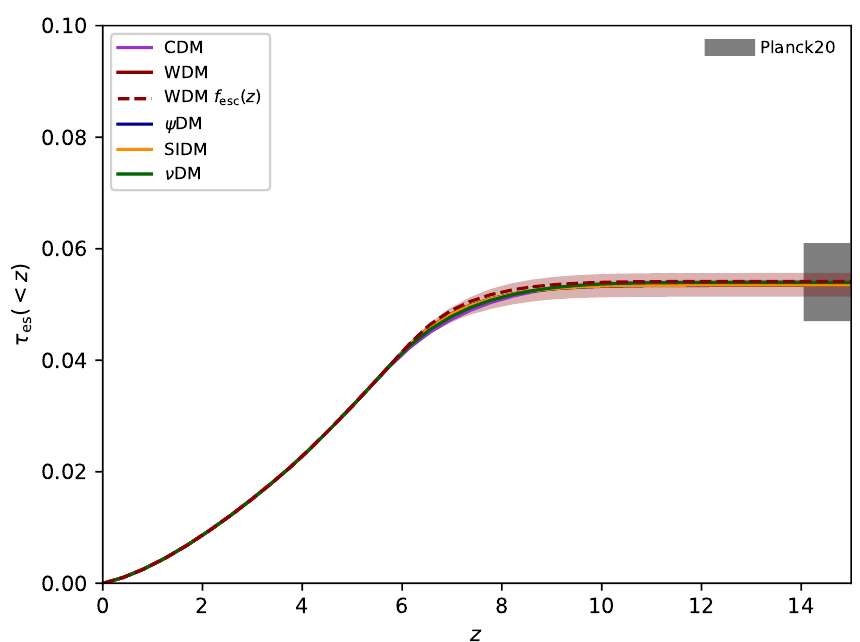
Figure 13. The optical depth to electron scattering τ es ( < z ) as a function of redshift z . Data are from [13] (shaded area). Lines as in Figure